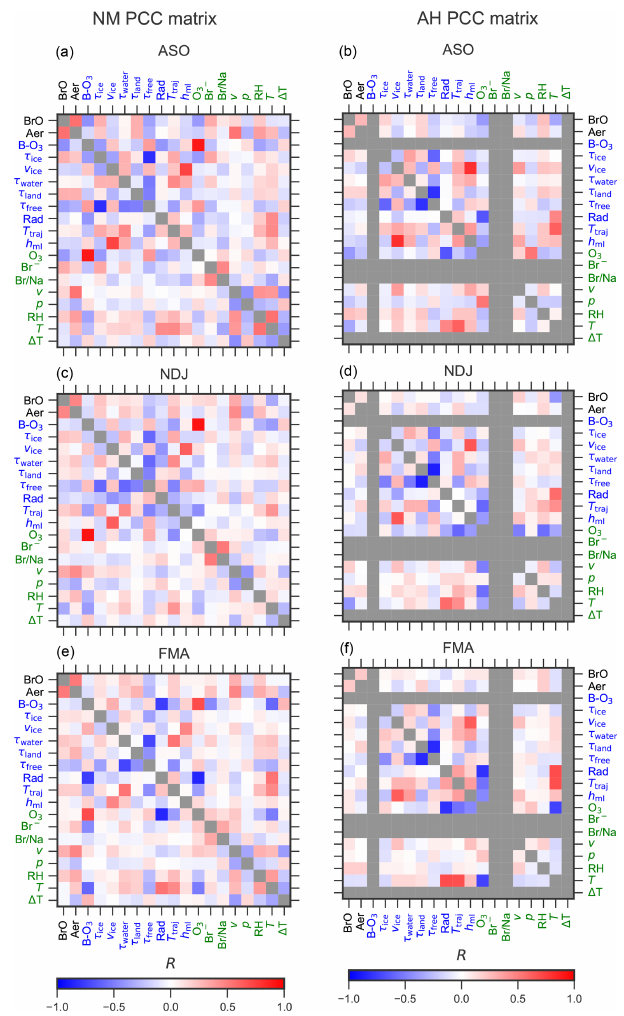
Figure 11. Matrix of Pearson correlation coefficients (PCCs) be- tween pairs of observed and modelled variables at NM (a, c, e) and AH (b, d, f) during each season. For a description of colum- nar and surface parameters, see Tables 5 and 4, respectively. Pos- itively correlated parameters are shown in red, and anti-correlated parameters are shown in blue. Grey elements indicate unavailable data. Columnar variables related to the trajectory simulations and the ozone soundings are labelled in blue, while surface variables observed on site are labelled in